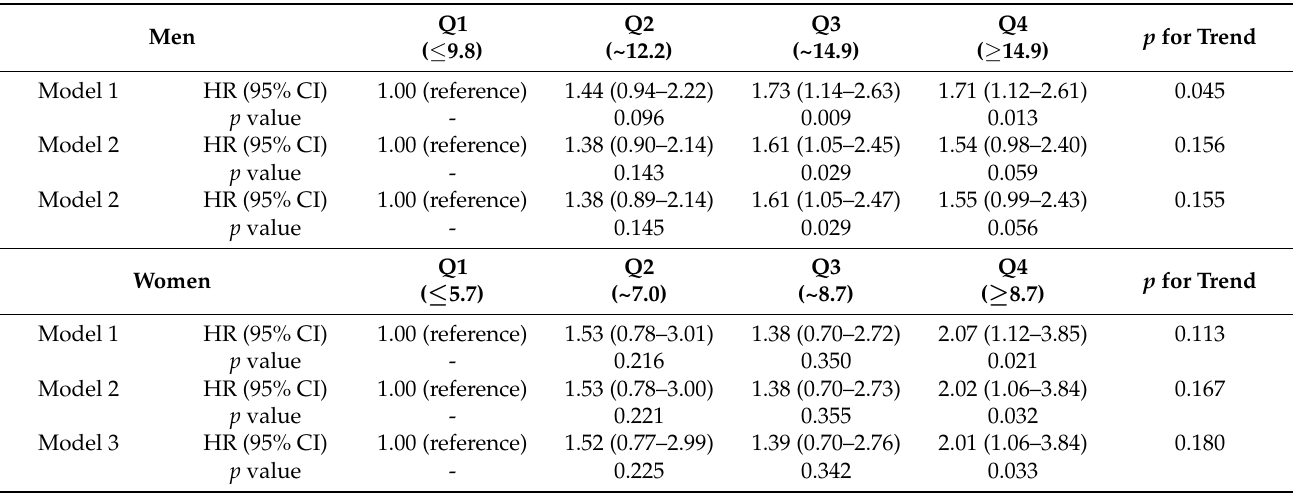
Model 1: adjusted for age. Model 2: adjusted for age, body mass index, smoking status, alcohol intake, and physical activity. Model 3: adjusted for age, body mass index, smoking status, alcohol intake, physical activity, mean arterial blood pressure, fasting plasma glucose, and Log C-reactive protein